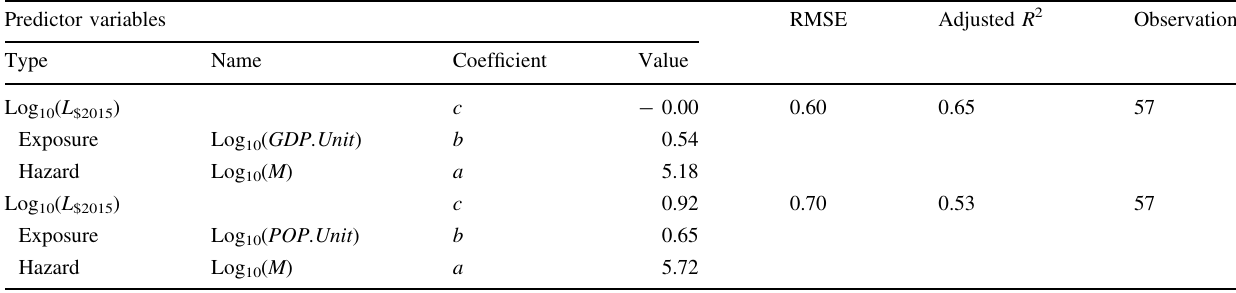
P : log 10 ( POP.Unit )